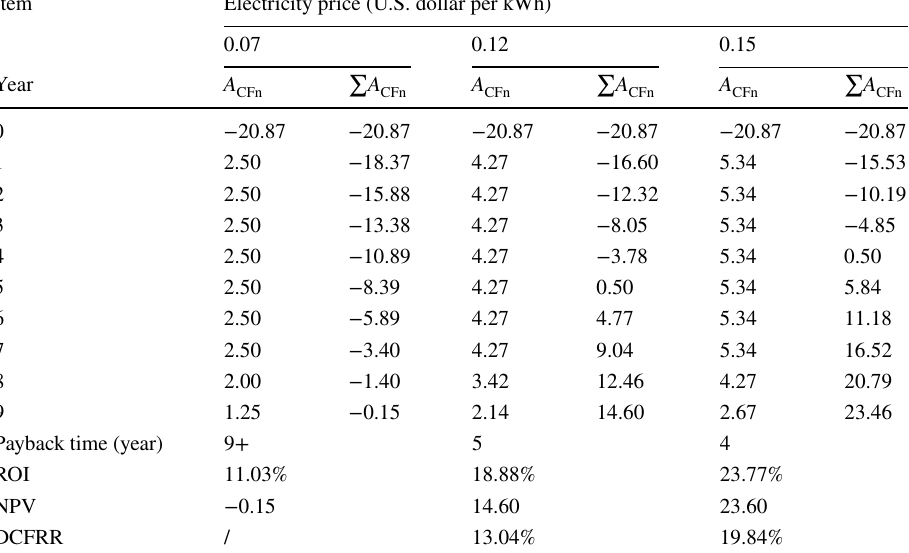
Table 6 Predicted annual cash flow and economic indicators for different electricity prices